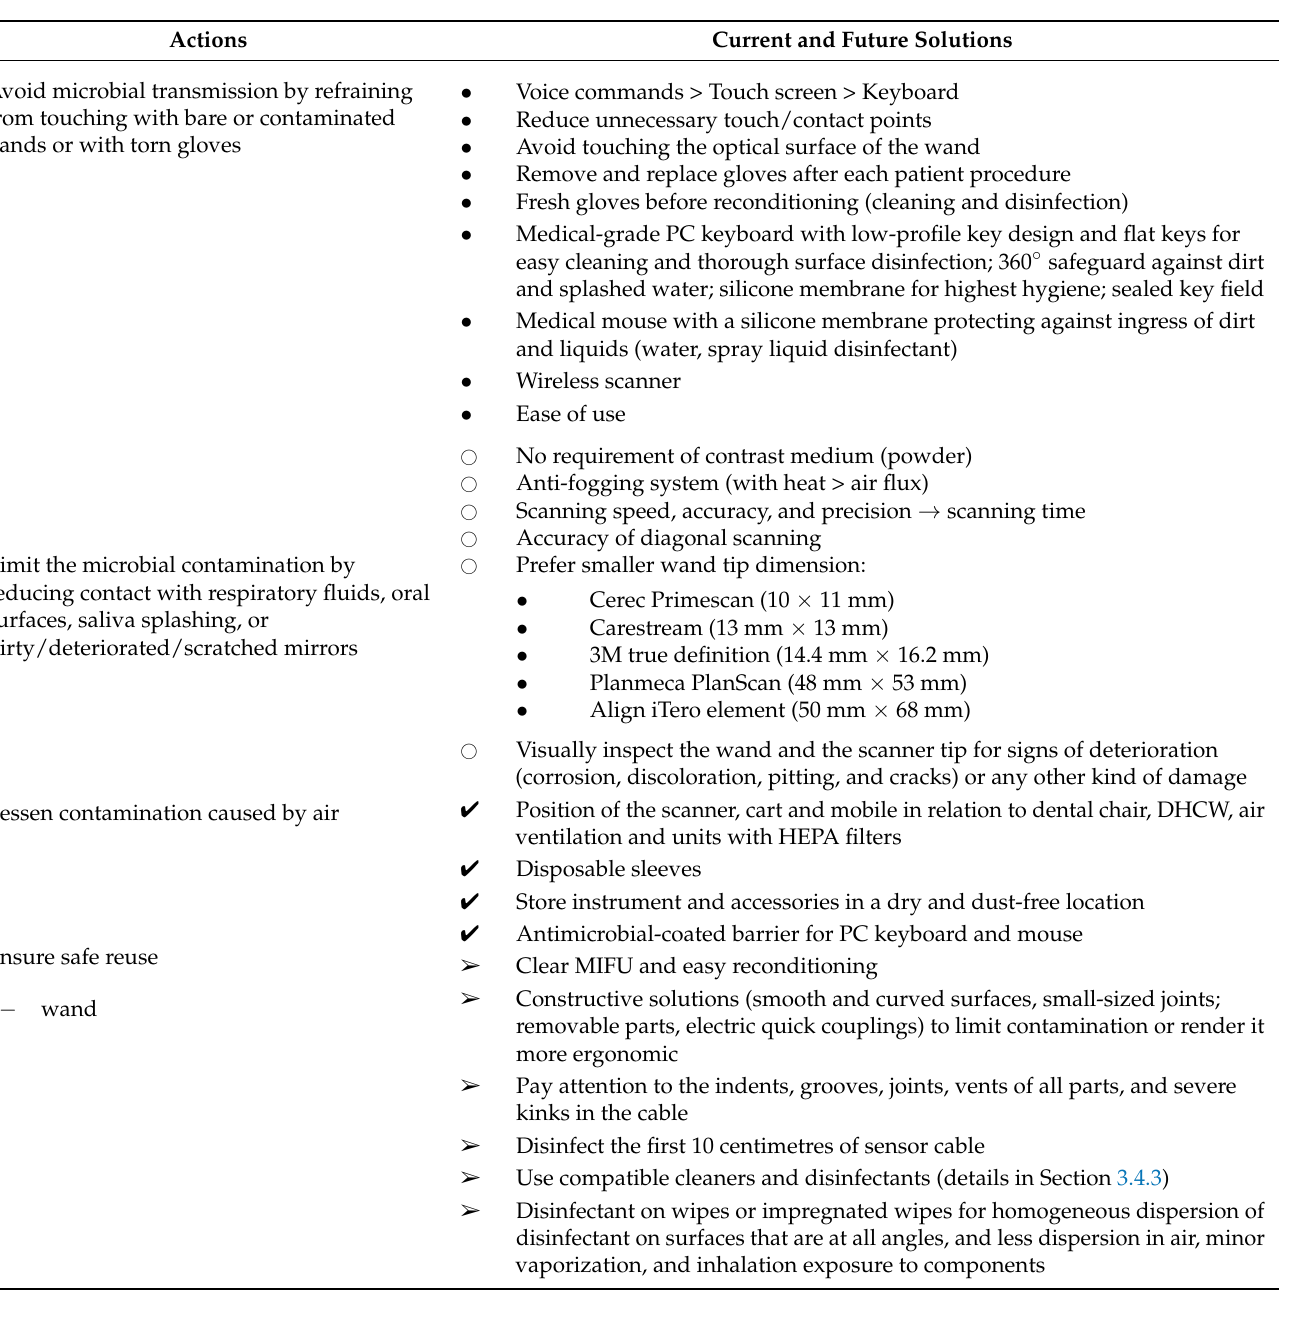
Table 2. Updated characteristics and procedures for IOS reconditioning after the lesson of COVID-19 pandemic